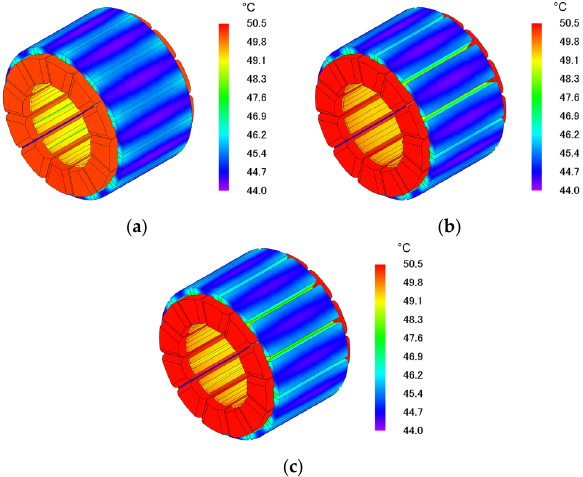
Figure 15. Temperature distributions in stator, when NdFeB is employed. ( a ) PM ‐ top; ( b ) PM ‐ bottom; ( c ) PM ‐ middle ‐ 1& ‐ 2.